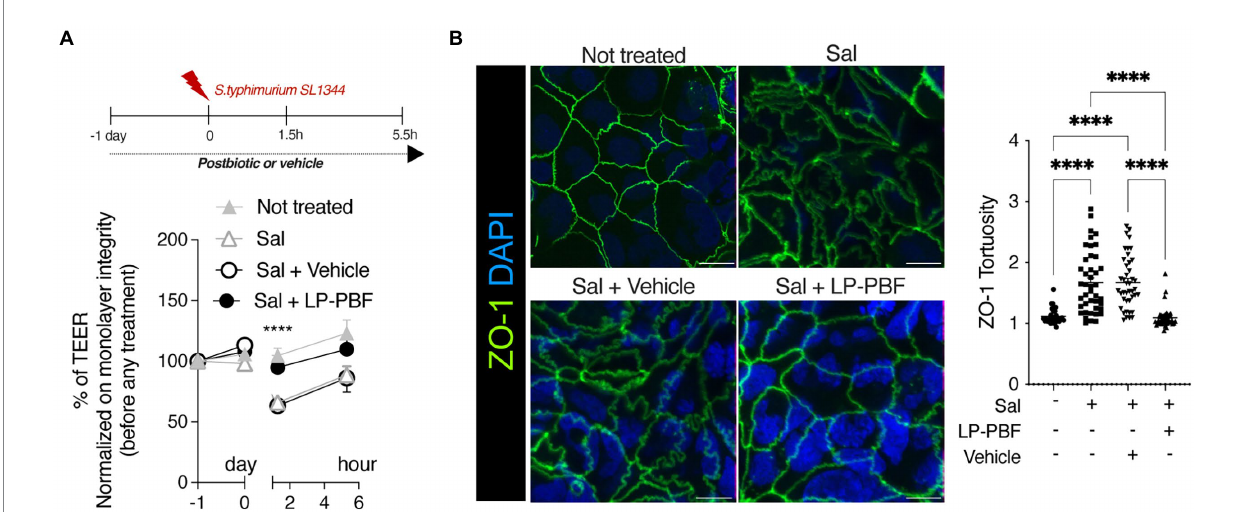
FIGURE 1 LP-PBF postbiotic treatment is able to preserve IEB properties. (A) Graph represents TEER values of Caco-2 cells that were pre-treated overnight with LP-PBF, then infected with S. typhimurium SL1344 for 1.5h, followed by recovery phase of 4h in the presence of LP-PBF. * Two-way ANOVA, Tukey’s multiple comparisons test. Above schematic representation of the experimental design. (B) Representative immunofluorescence images of ZO-1 done on Caco-2 cells after 1.5h of S. typhimurium SL1344 infection. Graph on the right represents quantification of ZO-1 junction tortuosity - ratio between junction length and Euclidean distance between its end. Scale bar - 10mm. Experimental design as in A.* Statistical analysis was evaluated using One- way ANOVA, Tukey’s multiple comparisons test. * p-value < 0.05; ** p -value < 0.01; *** p -value < 0.001; **** p -value <